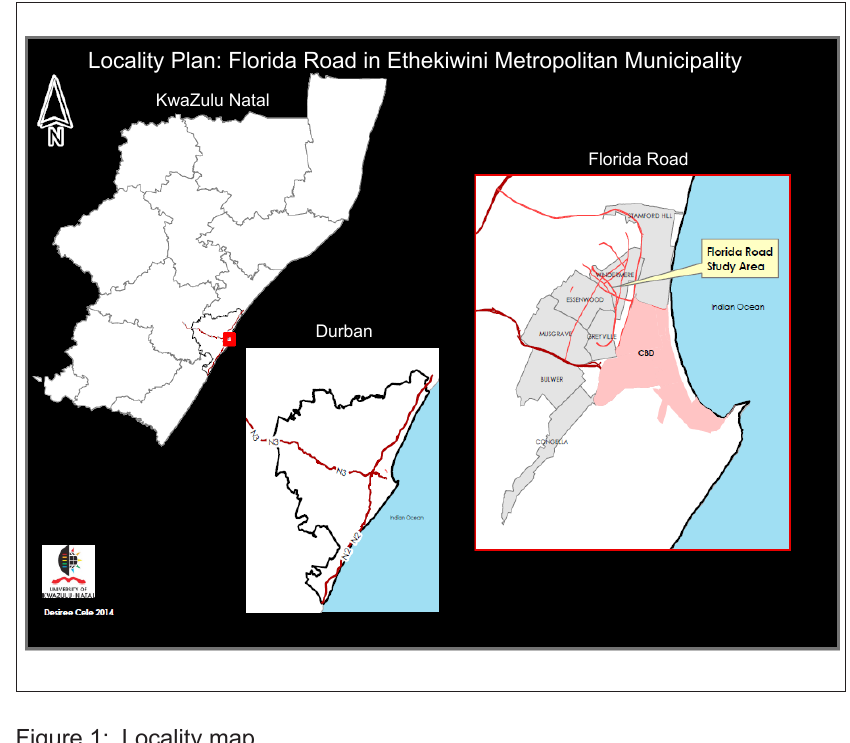
Figure 1: Locality